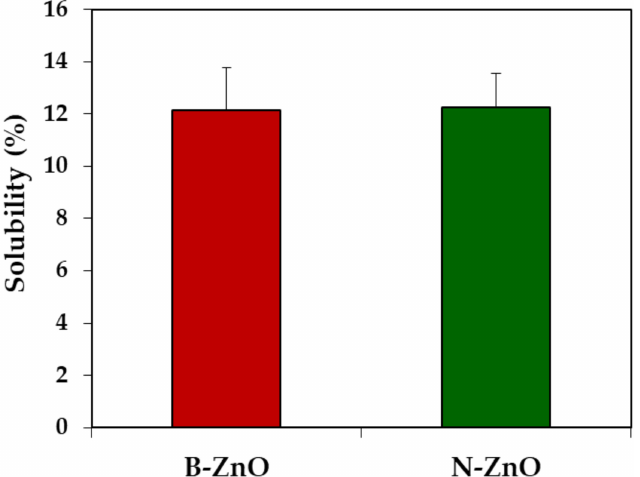
Figure 1. In vivo dissolution properties of ZnO particles in the gastric fluid at 15 min post-oral administration in rats. No significant difference between B-ZnO and N-ZnO was found ( p >